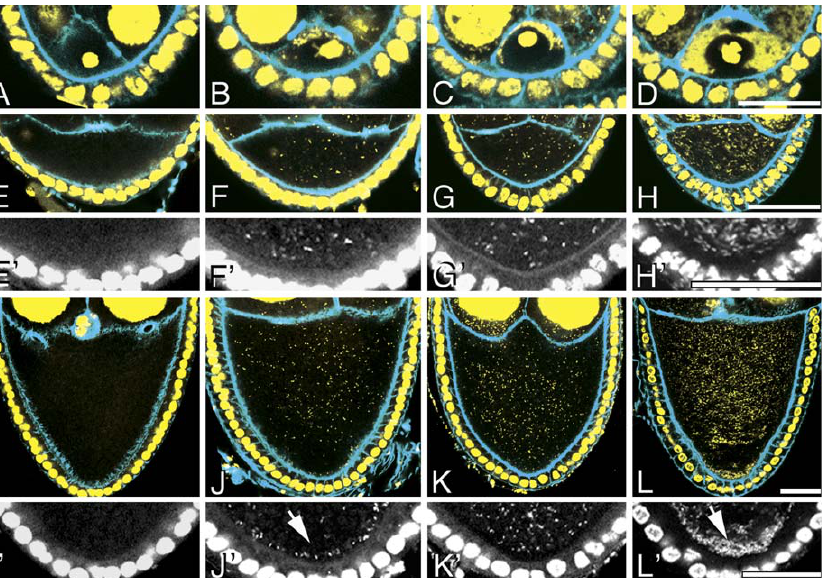
Figure 1. Localization of Wolbachia in Drosophila Oocytes (A–L) Oocytes from D. melanogaster and D. simulans are shown, posterior end down. Phalloidin (cyan) indicates actin, while propidium iodide (yellow) labels Drosophila and Wolbachia DNA. (E’–L’) Expanded views of the oocyte posterior show propidium iodide only. Arrows indicate posterior concentrations of wMel puncta. Panel rows, top to bottom: (A–D) stage 5, (E–H) stage 8, (E’–H’) stage 8 posterior, (I–L) stage 10A, (I’–L’) stage 10A posterior. Panel columns, left to right: (A, E, E’, I, I’) uninfected D. melanogaster , (B, F, F’, J, J’) wMel in D. melanogaster , (C, G, G’, K, K’) wRi in D. simulans , (D, H, H’, L, L’) wMel in D. simulans . (D) bar ¼ 12.5 l m. (H, H’, L, L’) bars ¼ 25 l m.